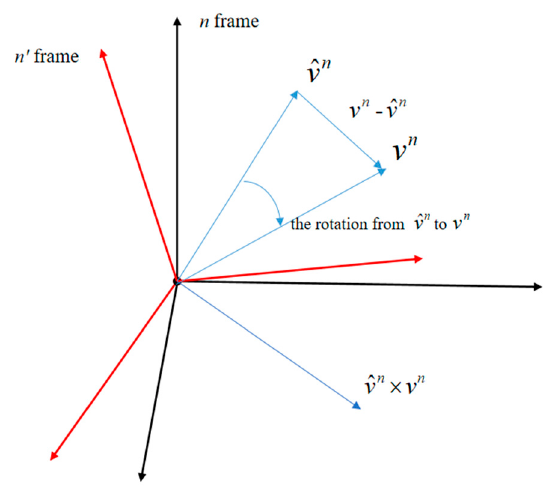
Figure 1. Diagram of the innovation vector.